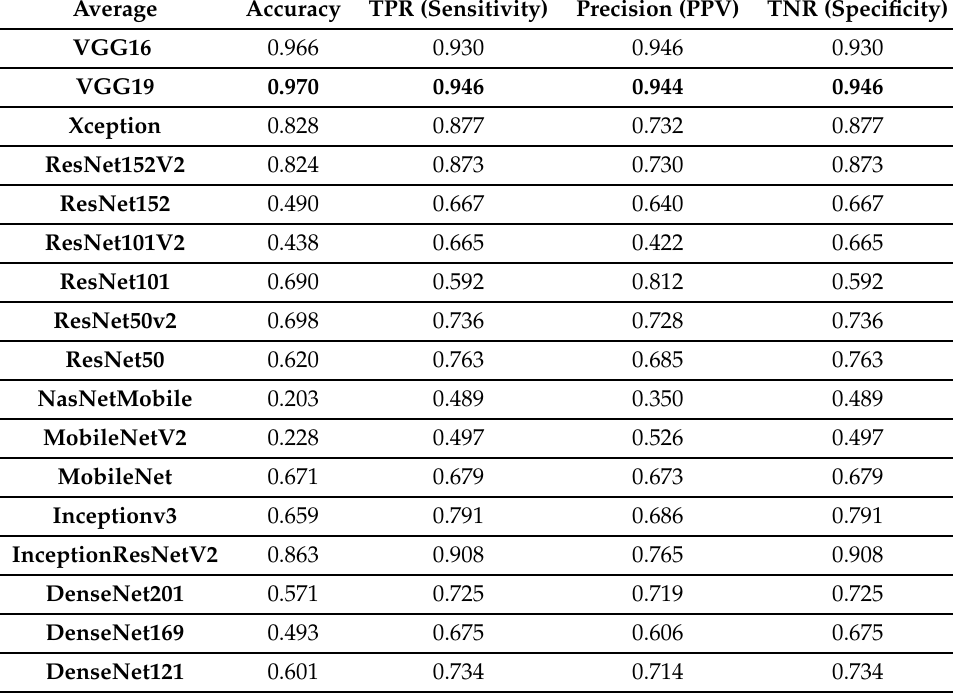
Table 10. 3 Folds Average CNN test results using PhysioNet